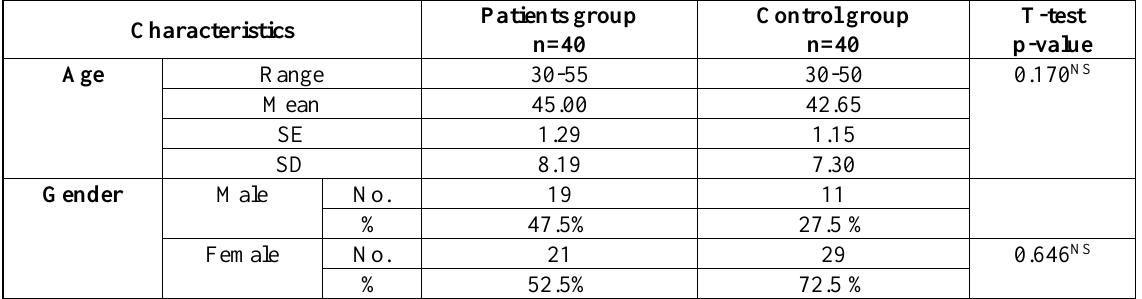
Table 1: Demographic Characteristics of Patients and Controls.